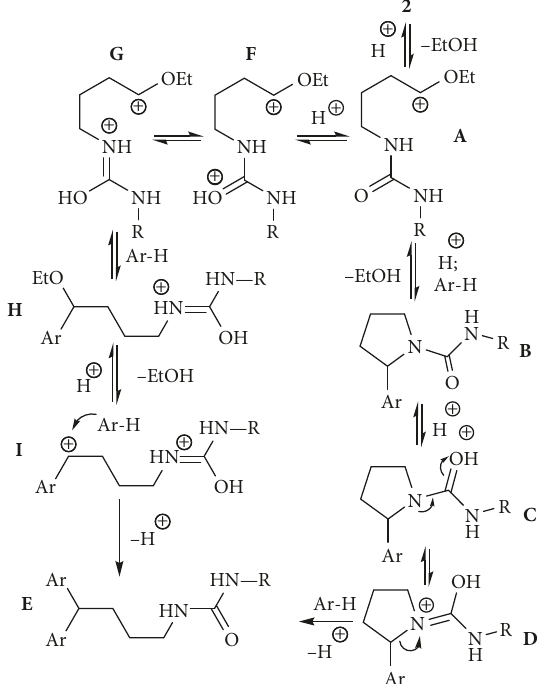
Scheme 6: Proposed mechanism for the substituted ureas